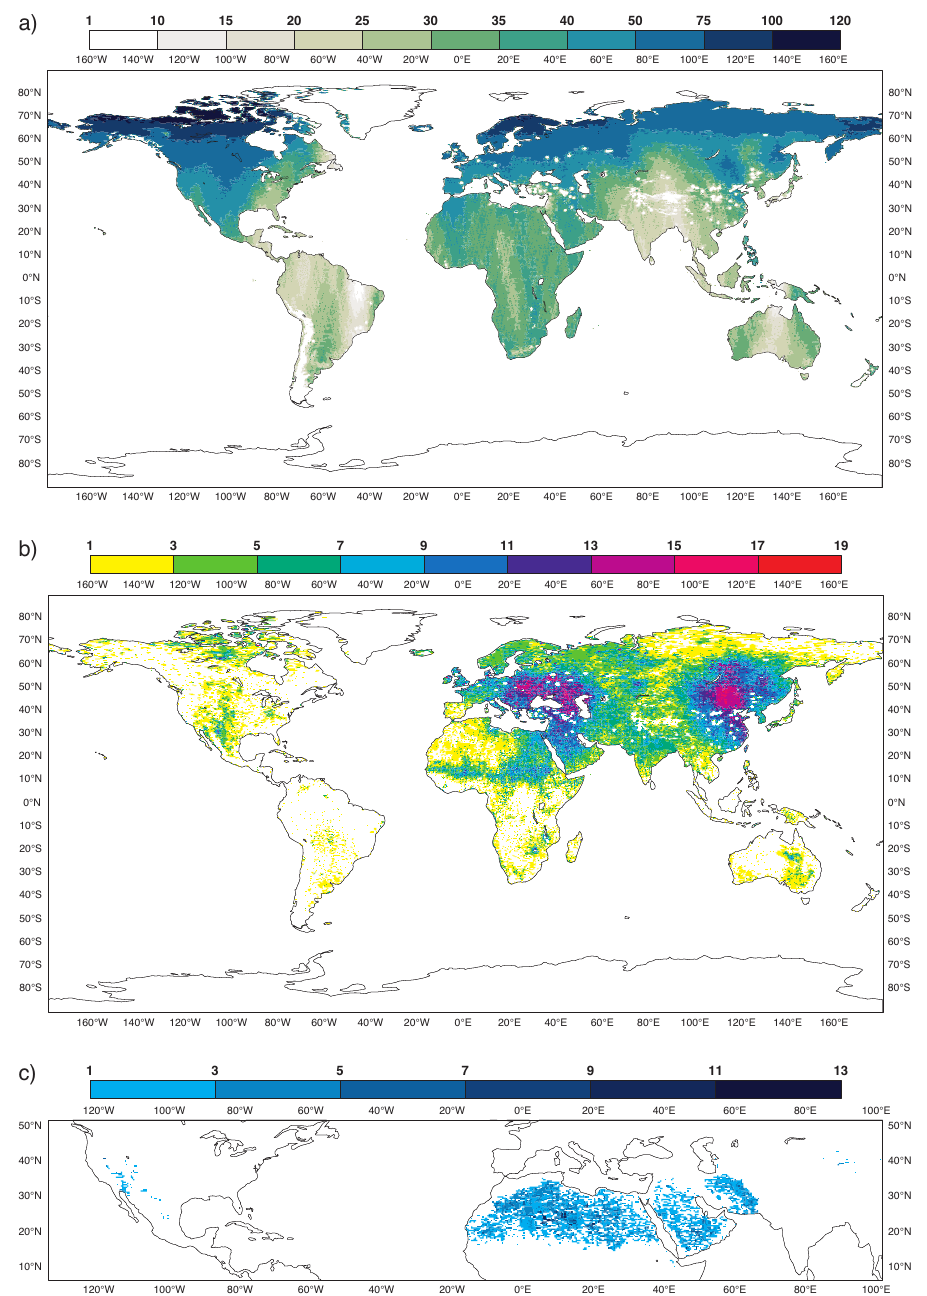
Figure 5. ( a ) Number of SMOS observations available for assimilation in each model grid point for experiment EXPT; ( b ) Number of SMOS observations rejected per grid point by the first-guess check; ( c ) Number of SMOS observations rejected per grid point by modeled T showing an absolute sensitivity larger than 250 K=m 3 m (cid:0) 3 . All three figures show B accumulated values for the period 1 to 15 July